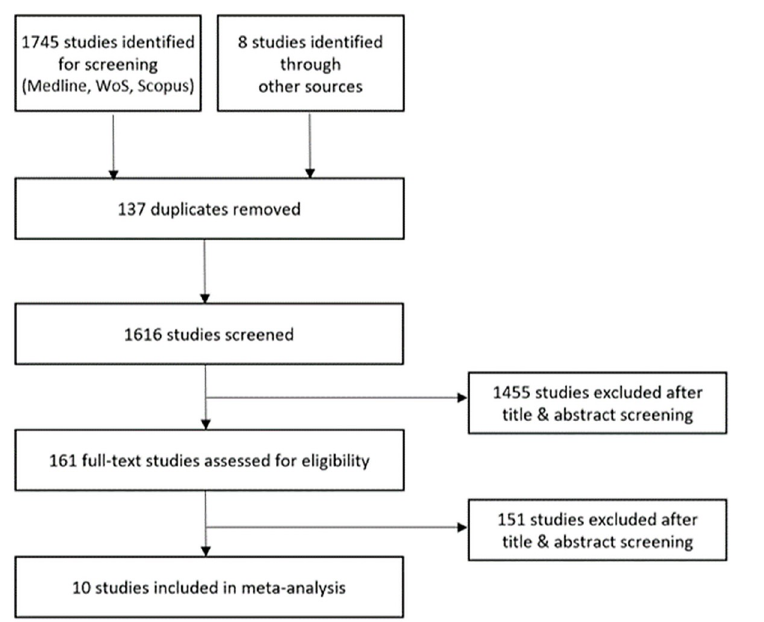
Fig 1. Flowchart of the 2-step study